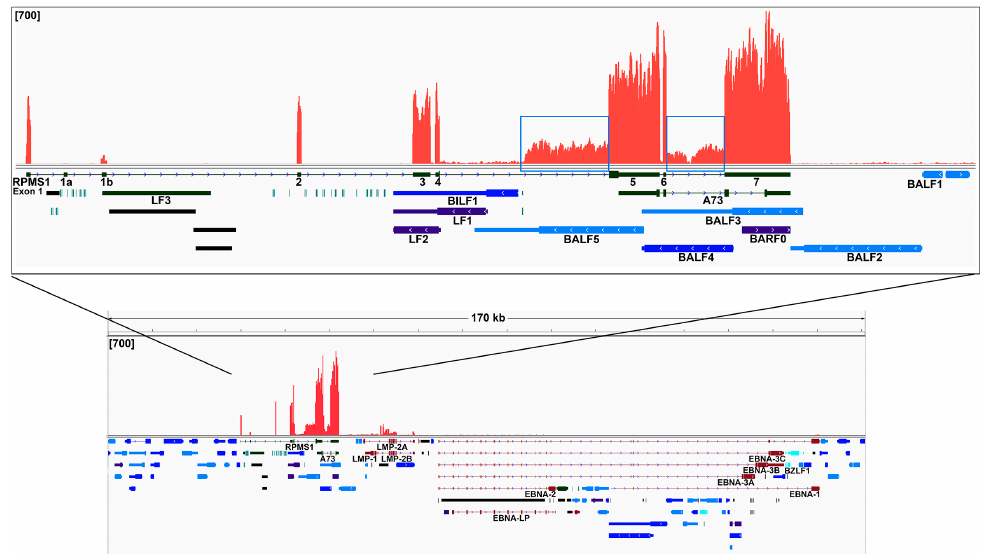
Figure 4. The EBV transcriptome in lung cancer. EBV genome coverage data for the EBV-high NSCLC is shown using the Integrative Genomics Viewer (IGV) based on the modified Akata-EBV genome. The modified EBV Akata genome was split between the BBLF2/3 and the BGLF3.5 lytic genes rather than at the terminal repeats to accommodate coverage of splice junctions for the latency membrane protein LMP-2. The y -axis represents the number of reads at each nucleotide position. The scale for the sample is set to a maximum read level of 700 reads. Blue features represent lytic genes, red features represent latent genes, green features represent potential noncoding genes, aquamarine features represent microRNAs, and black features represent non-gene features (e.g., repeat regions). Inset: Detailed read coverage data for the RPMS1/BamHI A region of the EBV genome.